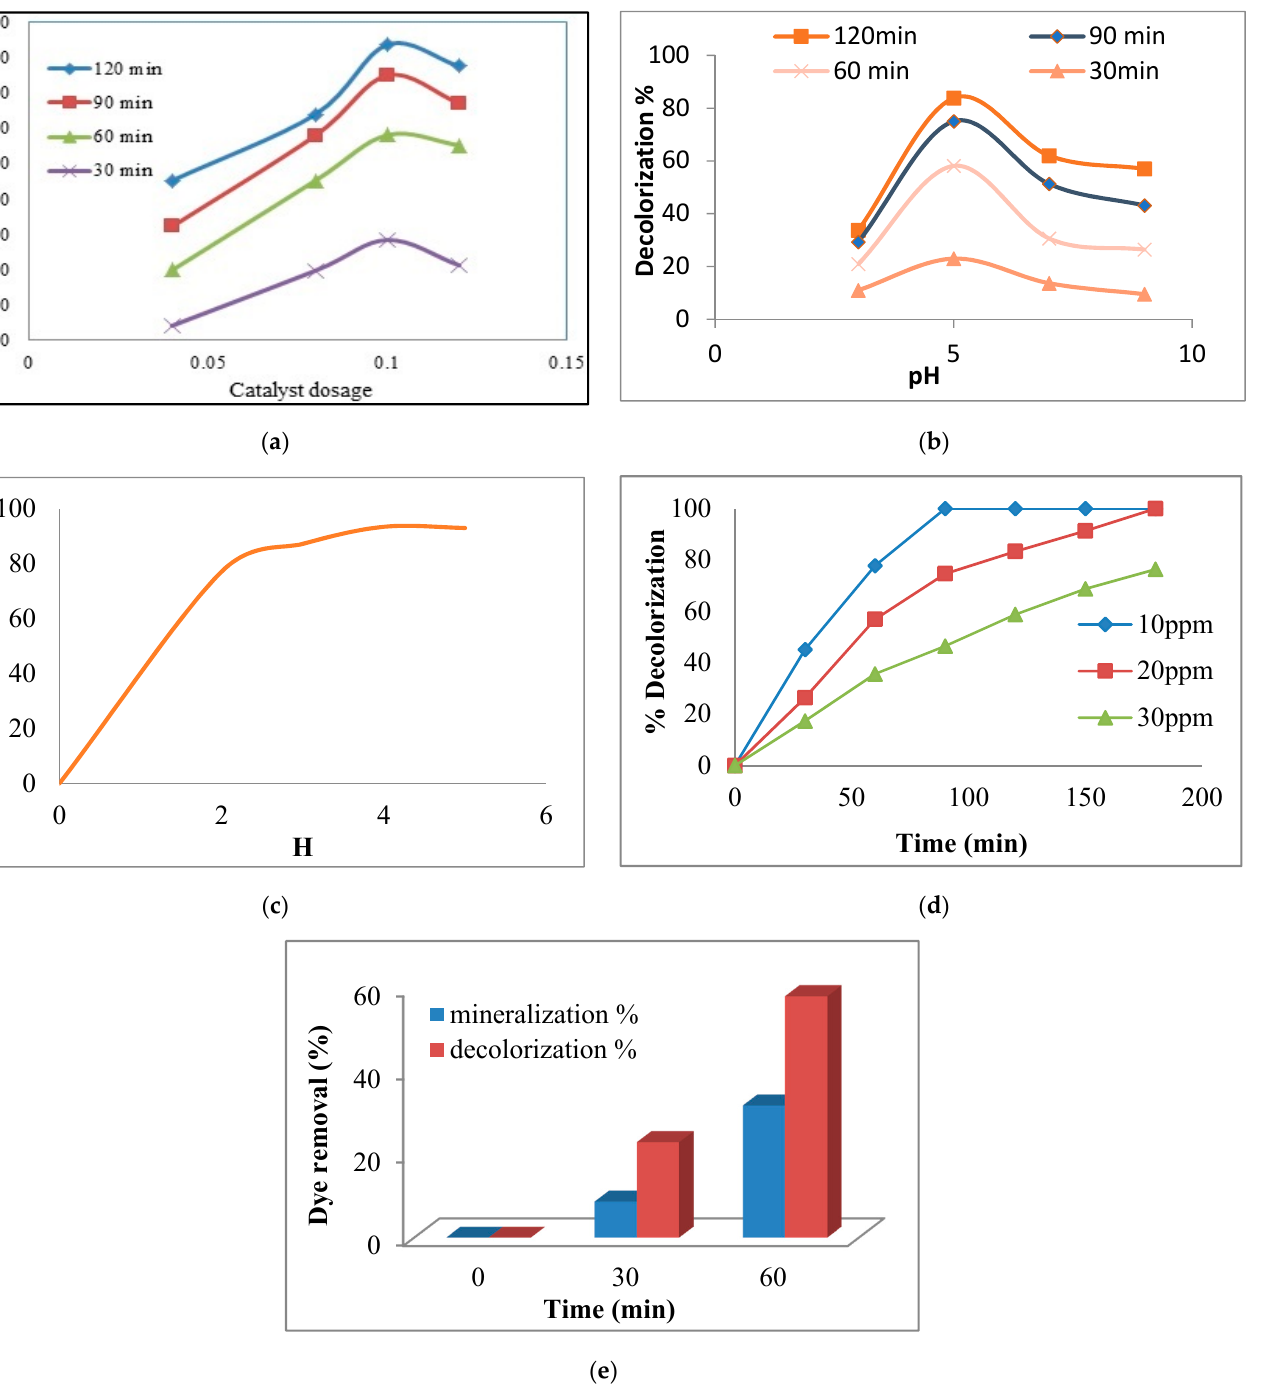
Figure 7. ( a ) Effect of catalyst dosage on decolorization efficiency at different HRTs (dye concentration of 20 ppm and pH 5); ( b ) the effect of pH on decolorization of RR198 at different HRTs (the dye concentration of 20 ppm and catalyst dosage 0.10 g/L); ( c ) decolorization plot on different amount of H [H 2 O 2 /Dye] (dye concentration of 20 ppm, catalyst dosage 0.10 g/L, and pH of 5); ( d ) decolorization of RR198 versus HRT for different dye concentration (catalyst dosage of 0.10 g/L and pH of 5); ( e ) decolorization and mineralization of RR198 at different HRTs (catalyst dosage of 0.10 g/L, dye concentration 20 ppm, and pH of 5) .